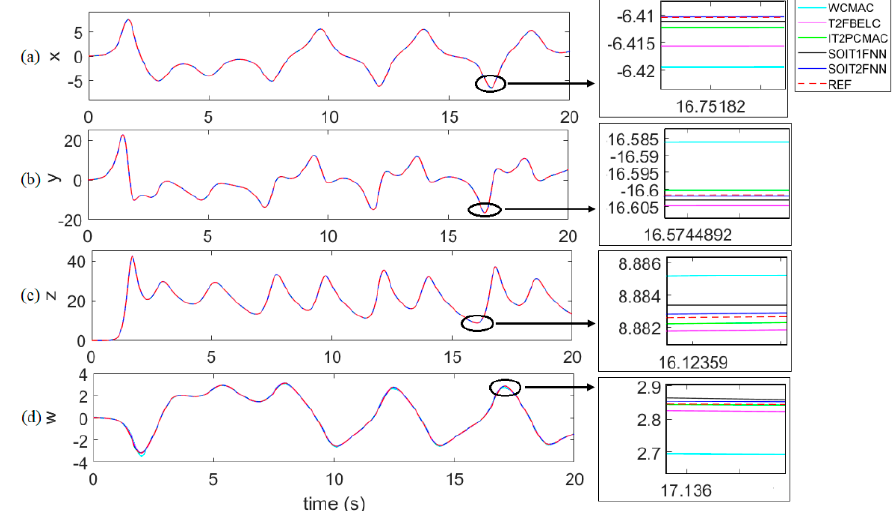
Figure 8. System outputs between the proposed SRIT2PC and other synchronization methods for Case